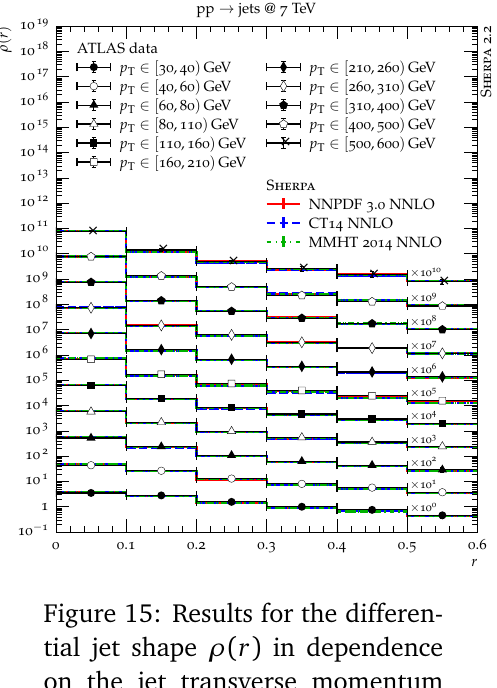
Figure 16: Results for the aver- age mean charged-particle trans- verse momentum in the transverse region in dependence of the leading jet p in inclusive jet and exclusive T dijet events in comparison to data from the A TLAS experiment [ 196 ]